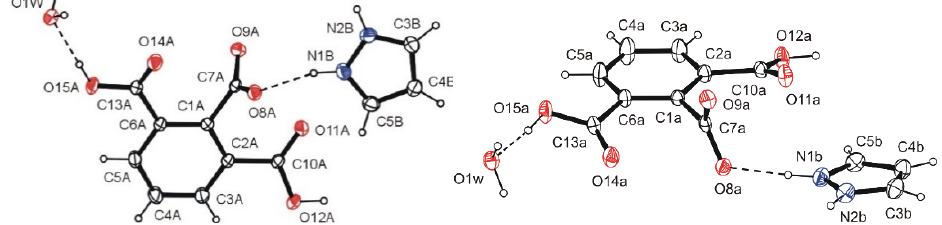
Figure 1. Two views of the molecule of PyrHem×H 2 O, showing the atomic labeling scheme. Non-H atoms are drawn as 30% probability displacement ellipsoids, and H atoms are drawn as spheres of arbitrary size.